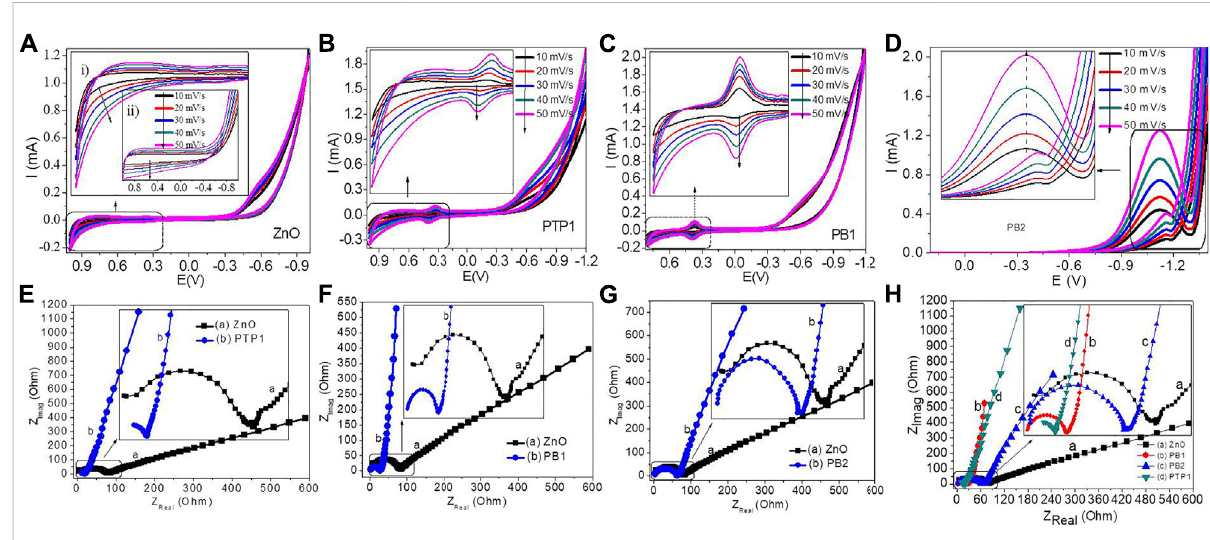
FIGURE 7 Electrochemical properties analysis: (A – D) . CV plots of ZnO NPs, PTP1, PB1, and PB2 NCs electrodes at different scan rates, respectively. (E – G) EIS plots of PTP1, PB1, and PB2 NCs, respectively. (H) the combined EIS spectra for ZnO, PB1, PB2, and PTP1 NCs (Inset: their magni fi ed EIS